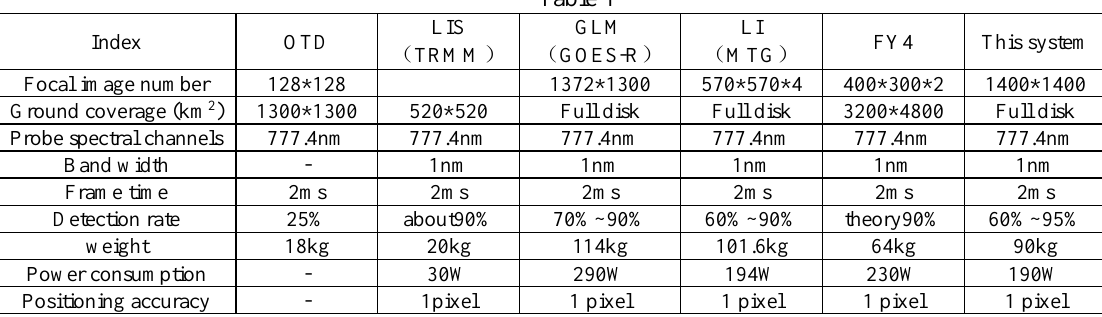
Algorithm theoretical basis document for the lightning imaging sensor[R] ． NASA Technical Report, AL 35812, 2000. An Instantaneous Point Source Detection and Extraction System for GEO Remote Sensing Satellite. Yukun Guo. 2018 ISPRS TCIII Mi-Term Symposium on Developments,